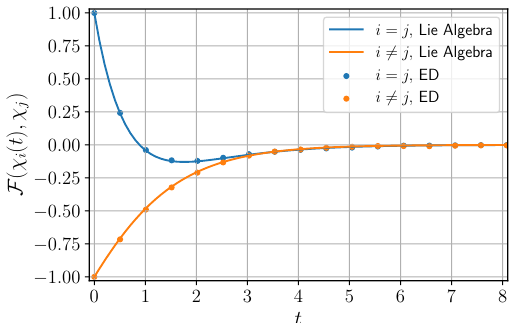
Figure 12 . A plot of the OTOC F ( χ i ( t ) , χ j ) in the Majorana model vs time, from both the ED of the original model in eq. (4.1) with explicit disorder average, and Lie Algebra (SU(2)) methods. Here N = 12 , q = 4 and the numerical ED results are computed using 200 disorder averages. syk